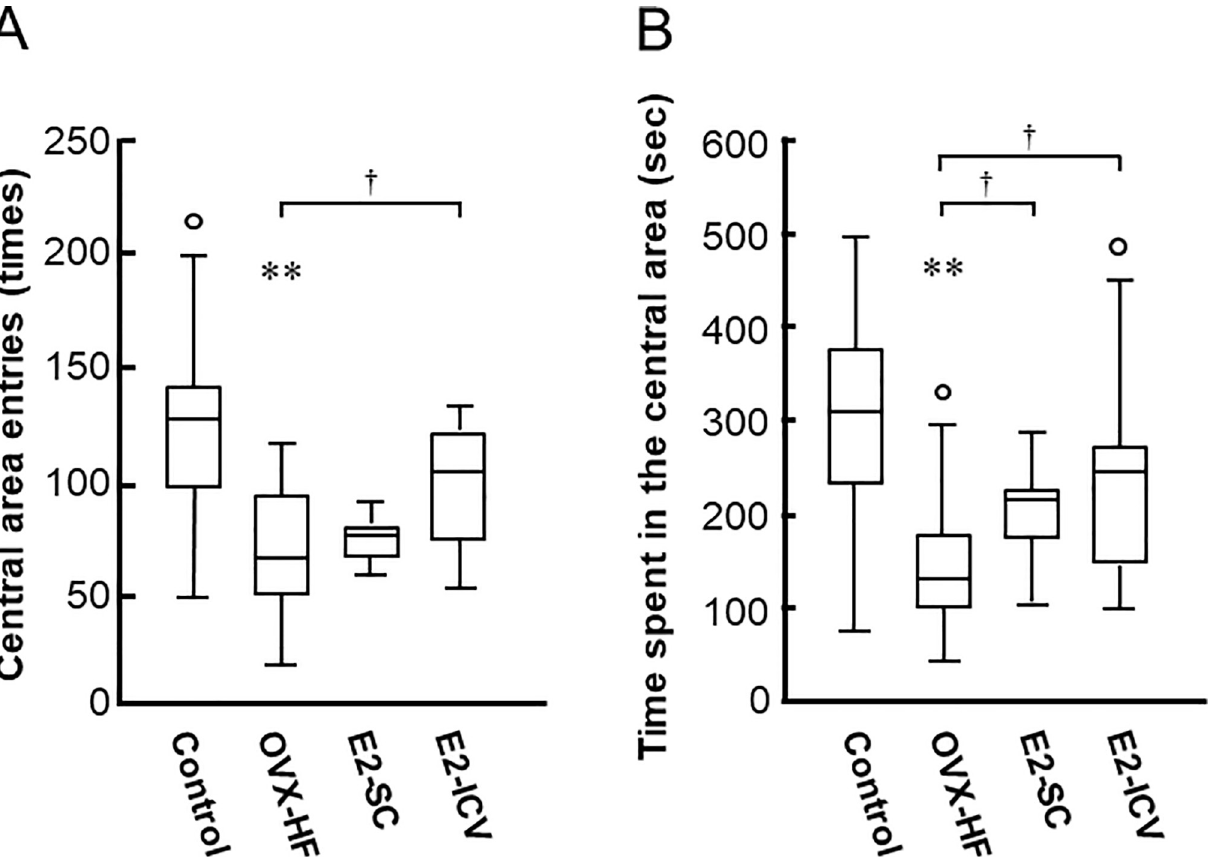
Fig 2. Effects of E2 administration on anxiety phenotypes in the open field test. Mice were placed at the center of an open field apparatus. The number of crosses into the central area (A) and the time spent in the central area (B) during a 25-min observation period were determined as indexes of the level of anxiety. Results are shown as Turkey style box plots with data falling outside the lower and upper quartiles plotted as circles. Values are the mean ± SE (control, n = 16; OVX-HF, n = 18; E2-SC, n = 11; E2-ICV, n = 10). P values were determined by the two-tailed Kruskal Wallis H-test with the Mann- Whitney U-test. �� P < 0.01 vs. the control group; † p < 0.05 vs. the OVX-HF group.